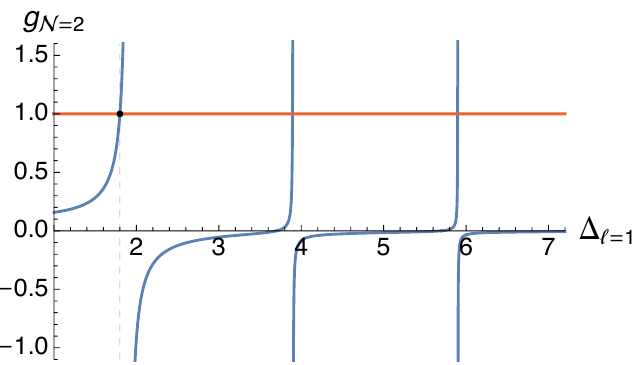
Figure 8 . Solutions of eigenvalue problem for scalar bilinears of spin-1 in d = 2 . 8 dimensions. The vertical dashed line corresponds to the unitarity bound. The black point represents the stress tensor